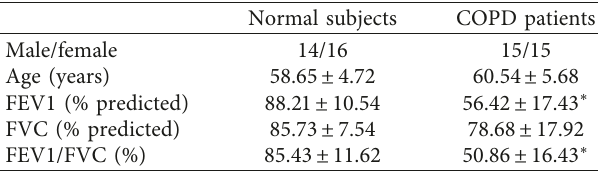
Table 1: Clinical characteristics of normal subjects and COPD